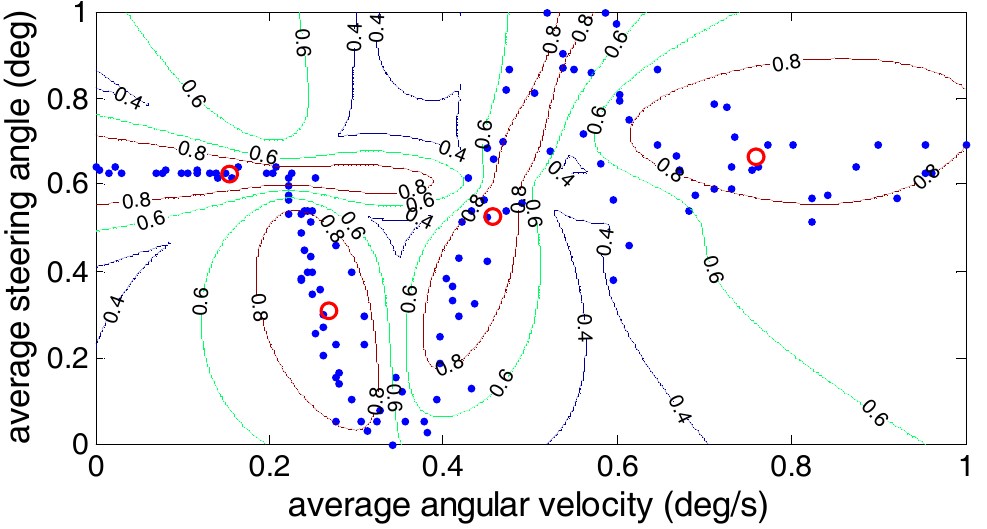
Figure 12. Visualization of the classification results of the driver’s steering intention based on the Gustafson–Kessel algorithm. Appl. Sci. 2017 , 7 , 1014